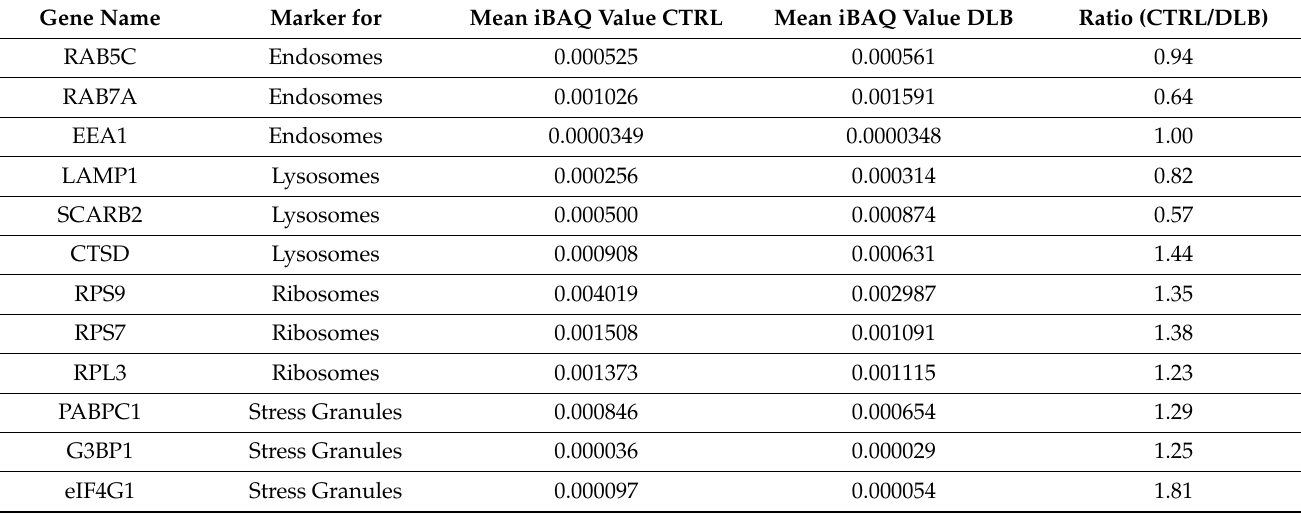
Table 3. Abundance levels of marker proteins for endosomes, lysosomes, ribosomes and stress granules in NMGs of CTRL and DLB